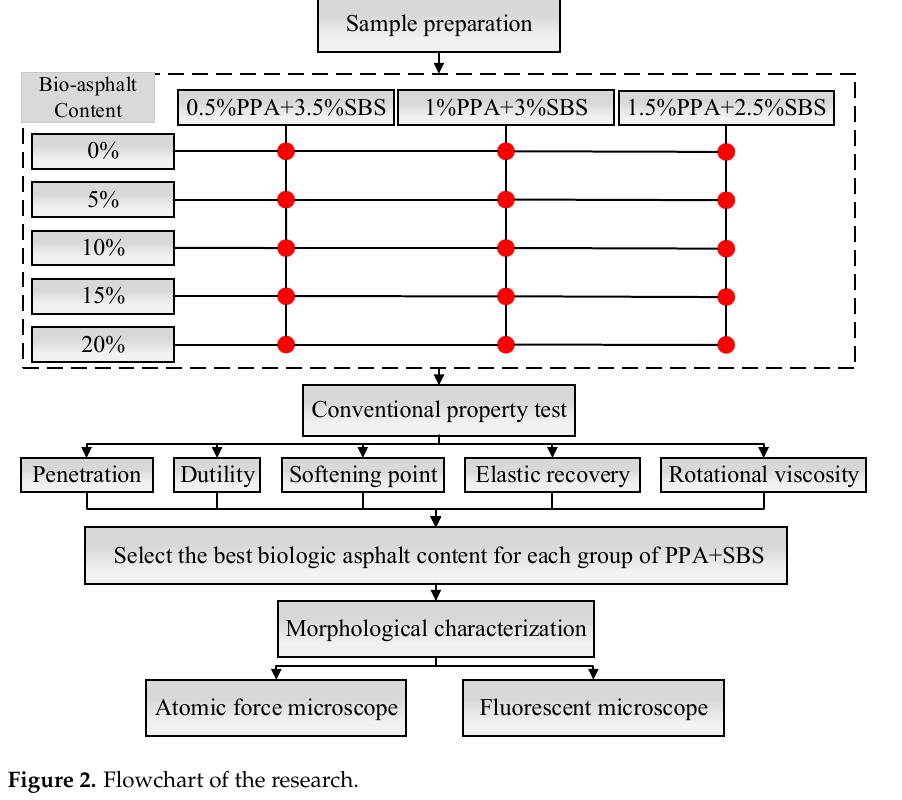
Figure 2. Flowchart of the research.